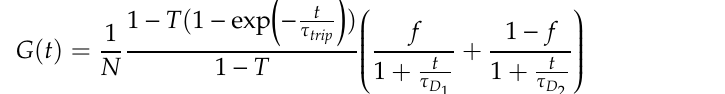
Figure S1: S1 Identification of cardiac myocytes and myofibroblast in primary culture, Figure S2: Fluorescent components incorporated into the PM of cardiac myofibroblasts, Figure S3: Increase of background signal when using BFGl-GM1 in cells and model systems, Figure S4: Di ff usion analyses of sphingomyelin in di ff erent membrane